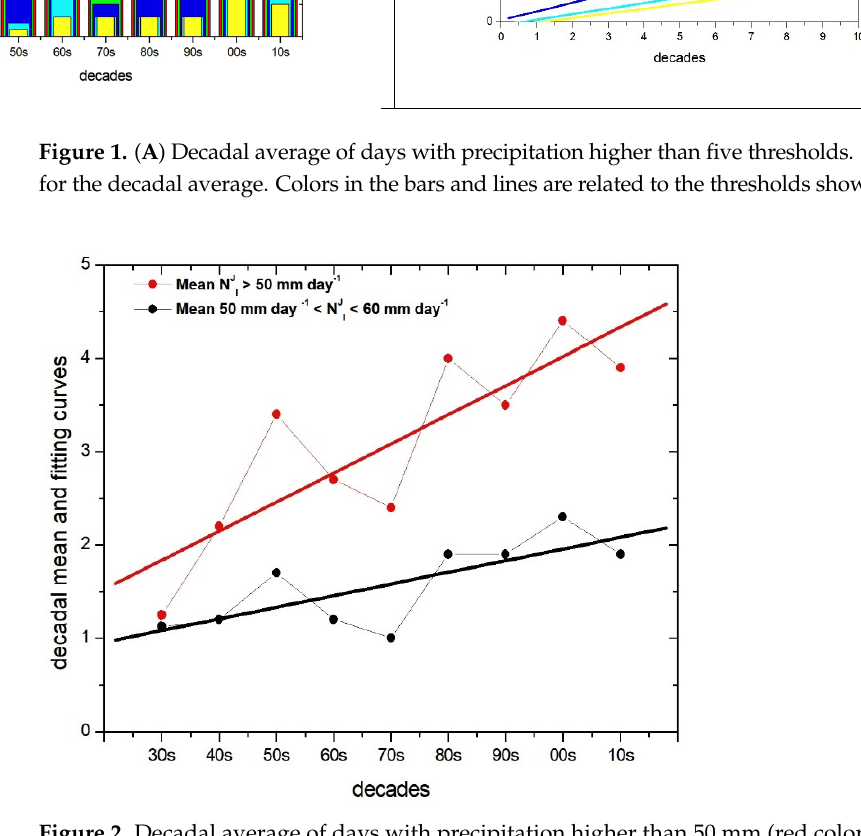
Figure 2. Decadal average of days with precipitation higher than 50 mm (red color) and days with precipitation higher than 50 mm and lower than 60 mm (black color).